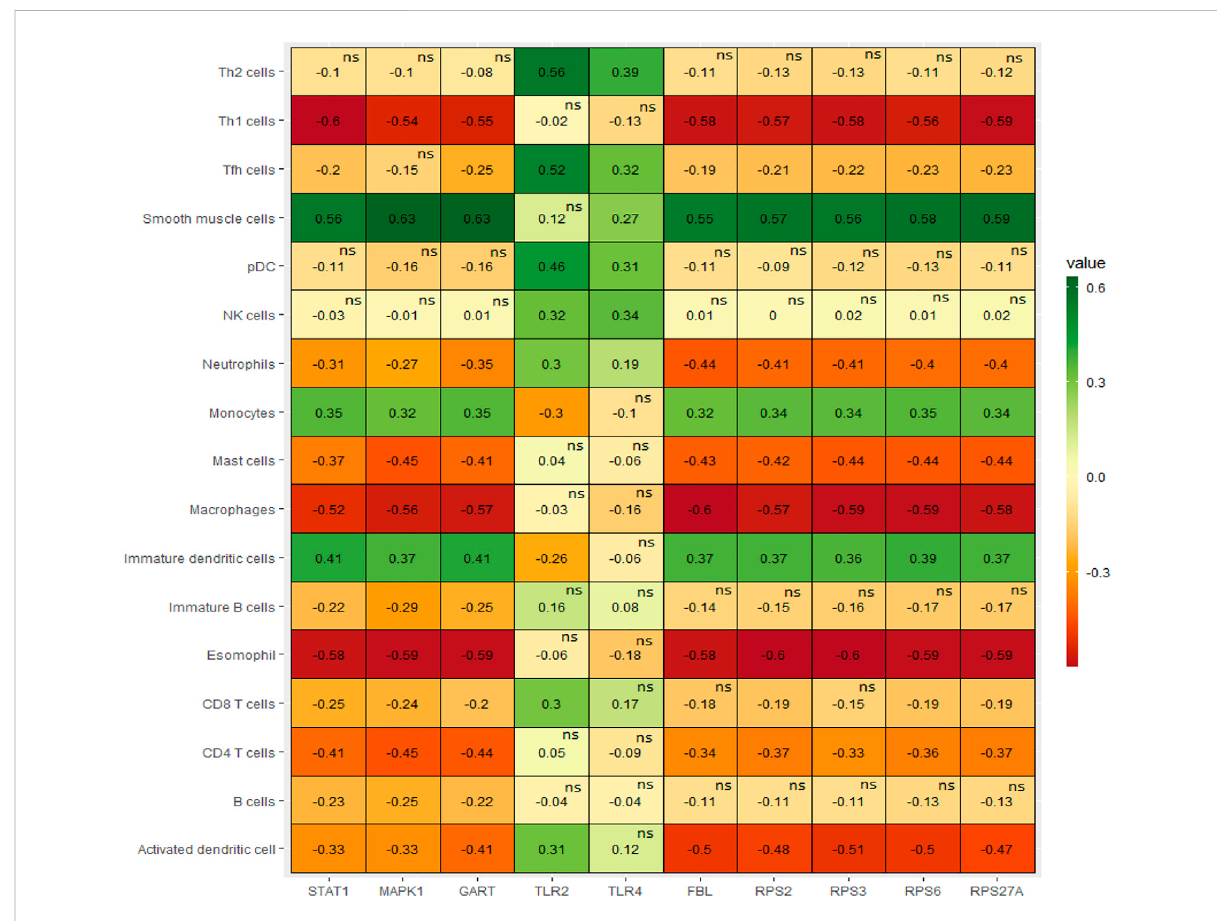
FIGURE 6 The expression levels of hub genes are signi fi cantly correlated with ssGSEA scores of immune cells in PAH (Spearman ’ s correlation test, p <